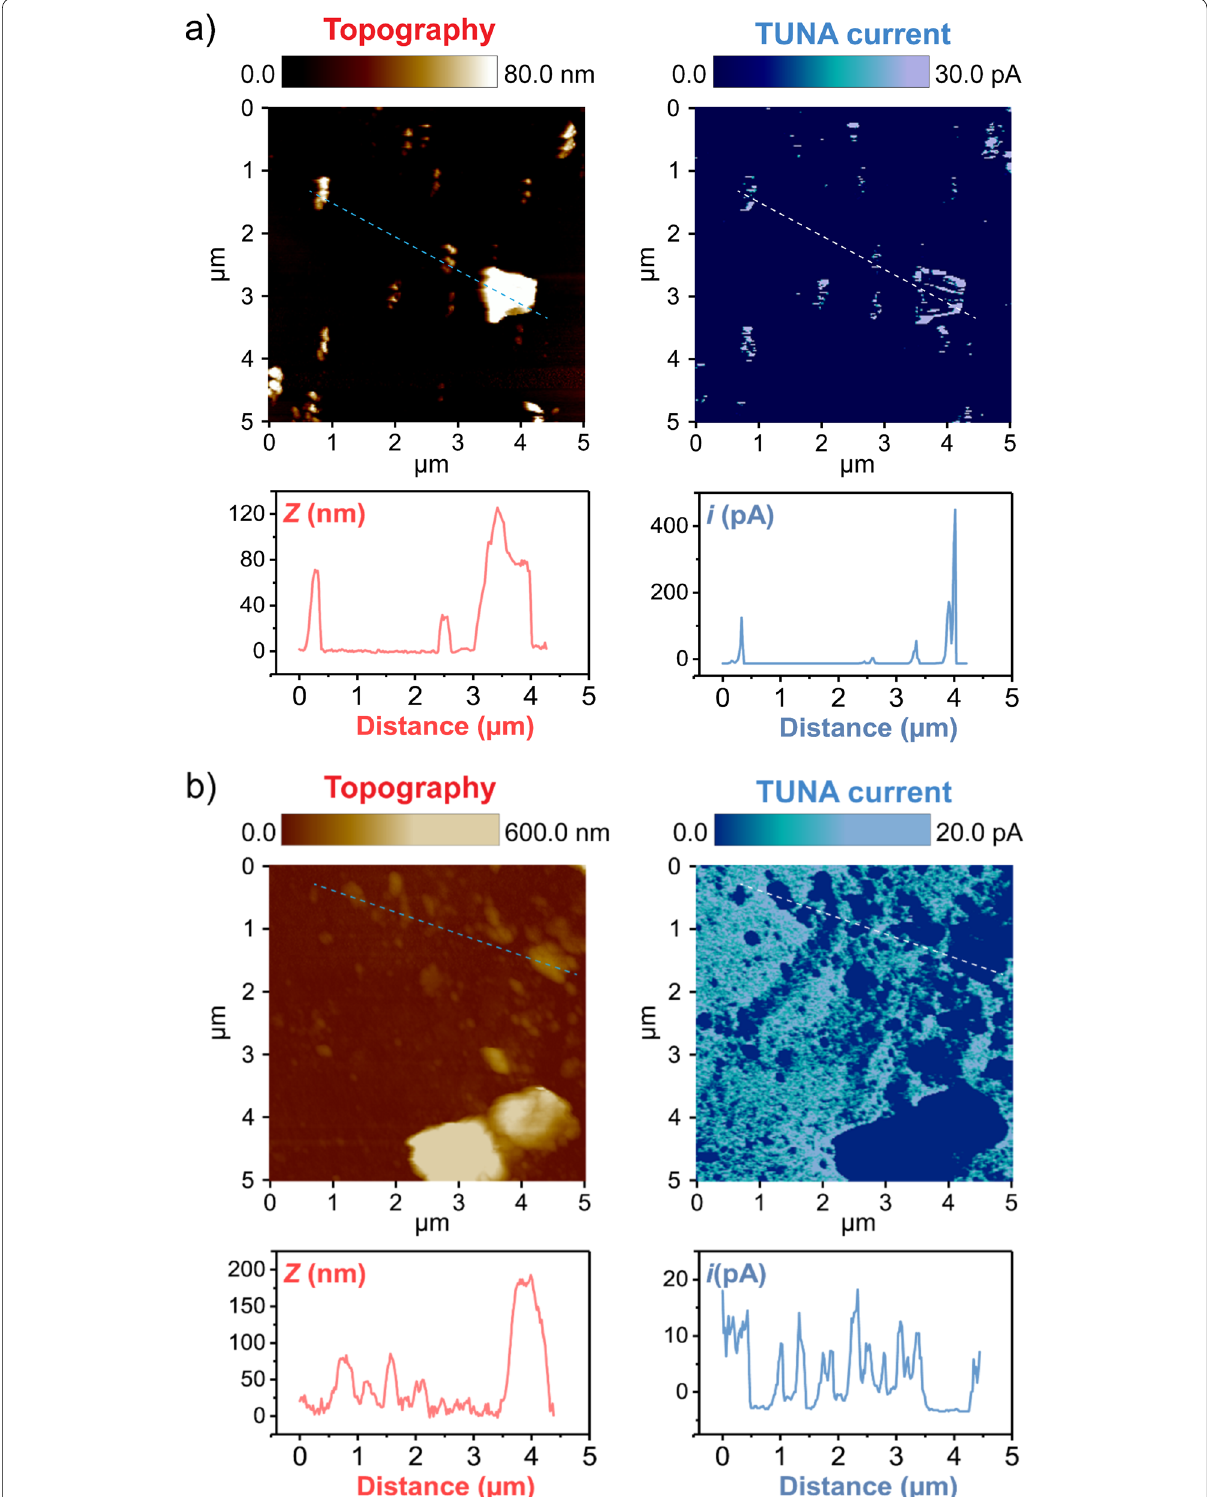
Fig. 2 Topography and TUNA current mapping. a Chars derived from starch at 700 °C (st700) and b chars derived from indigo dye at 400 °C (ind400). Cross sections of the topography and current images taken along the dash lines shown in the images were displayed in the line plots below. Bias voltage applied for current mapping was